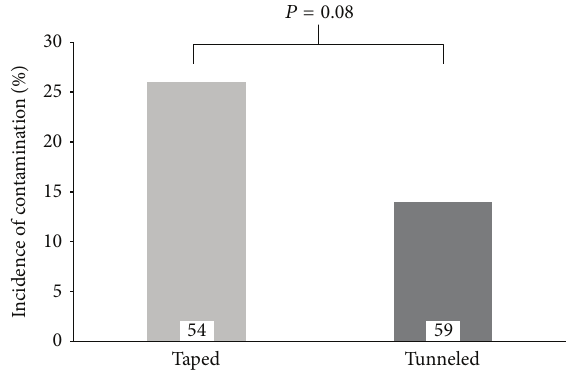
Figure 5: Overall incidence of bacterial contamination. 113 epidural catheter tips (59 tunneled, 54 taped) were available for microbiolog- ical screening. Fisher’s exact test showed no statistical significance ( 𝑃 = 0.08